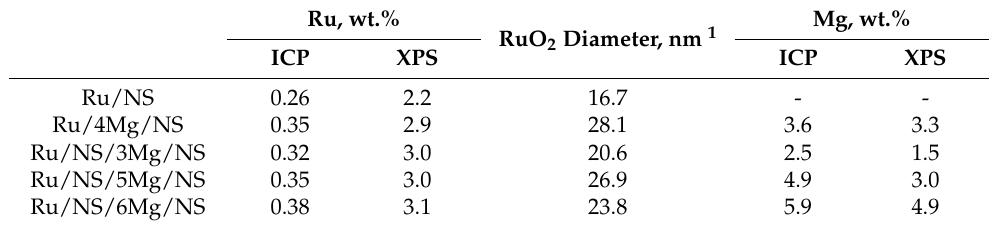
Table 2. Ruthenium content derived from ICP and XPS and ruthenium (IV) oxide particles’